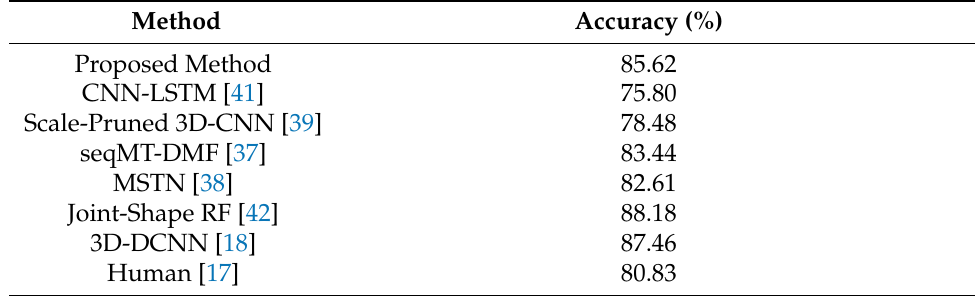
Table 2. Quantitative comparison with other recent state-of-the-arts on the NTHU